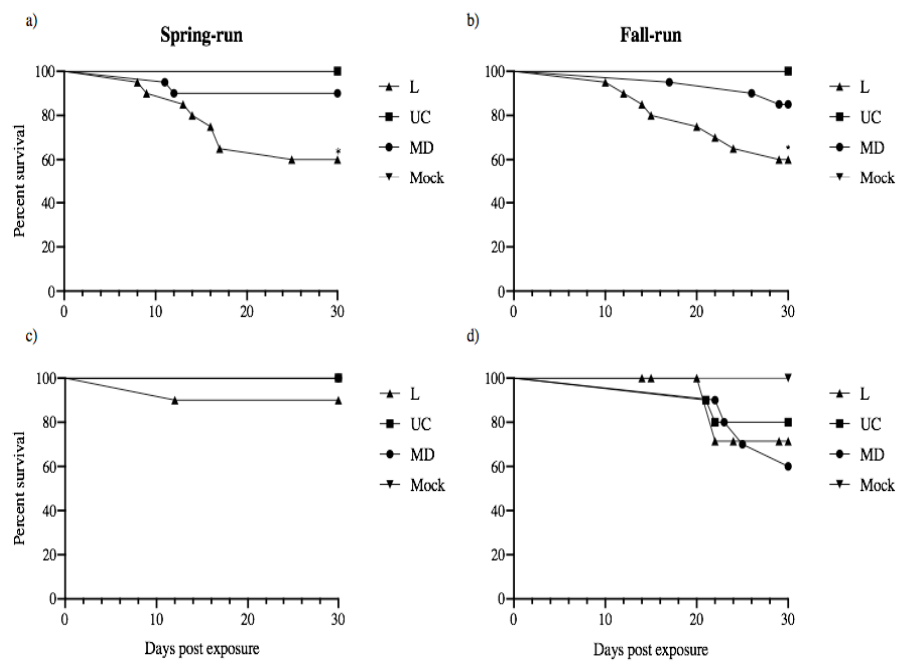
Figure 8. Daily cumulative percent survival of juvenile spring- ( a , c ) and fall-type ( b – d ) Chinook salmon exposed to L, UC and MD strains of IHNV or virus-free media (Mock). Experimental host populations were monitored for mortality over the course of 30 days. 20 fish from each treatment group remained together in batch following the immersion challenge ( a , b ), whereas 10 of the initial thirty fish exposed were isolated to quantify the viral shedding of each individual ( c , d ). Survival curves were constructed for each group of 20 fish per batch treatment and those fish individually monitored for viral shedding. Asterisks indicate that fish in the positive control L genogroup IHNV treatment had significantly lower survival than batch-held fish in the other viral strain treatments ( p < 0.001). No significant reductions in survival were observed in batch-held or isolated fish exposed to the UC and MD virus treatments.